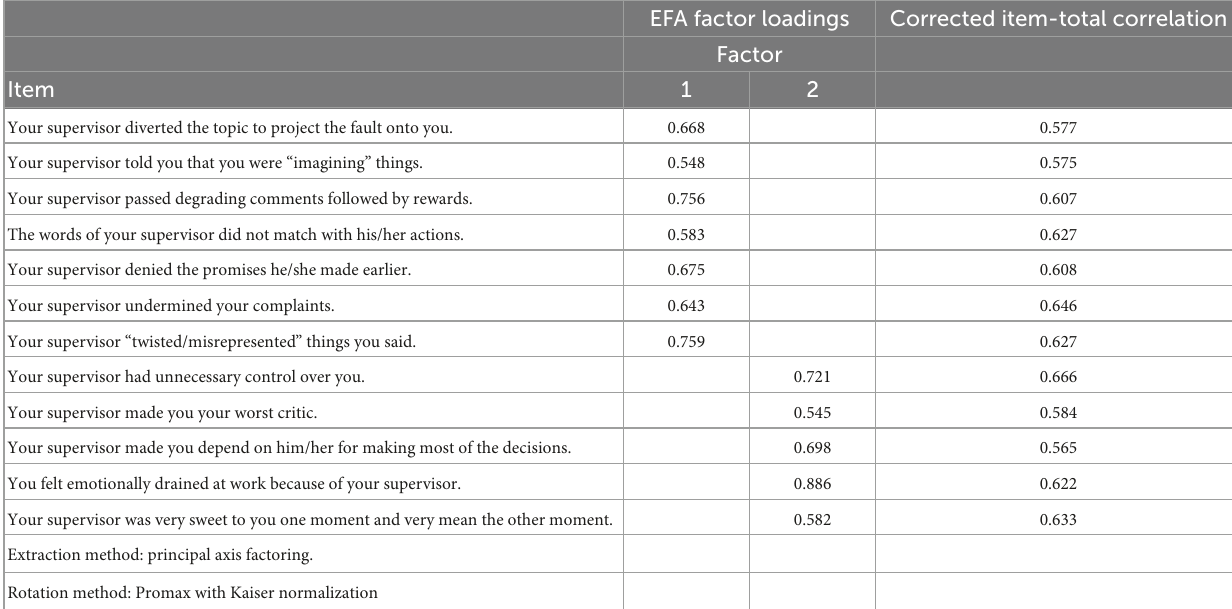
TABLE 2 Final items, factor loadings, and corrected item-total correlations. How often did you have these experiences at work in the past 6